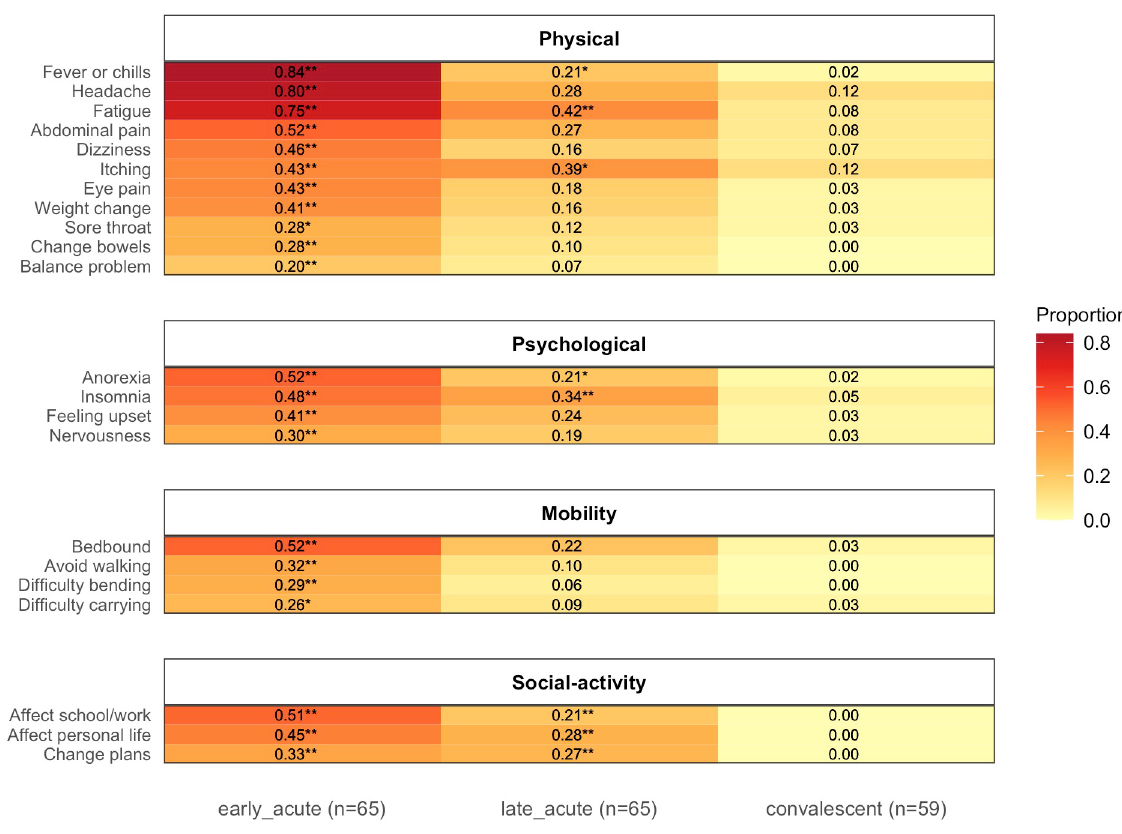
Fig 1. Heatmap: Proportion of participants reporting symptoms or effects by illness phase (left column: early-acute, middle column: late-acute, right column: convalescent phase). The proportion is represented by the redness of the cell and the actual proportion is shown by the number in each cell. � Fisher’s exact test: P < 0 . 05 , �� Fisher’s exact test: P < 0 . 01 .This includes only symptoms that were reported in significantly higher frequency in the early-acute or late-acute versus the convalescent phase of